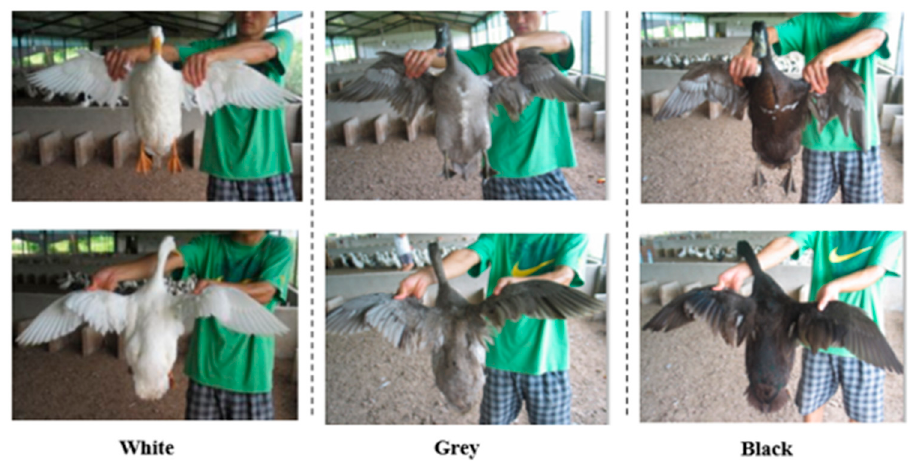
Figure 1. Three groups of phenotypes of duck plumage color.